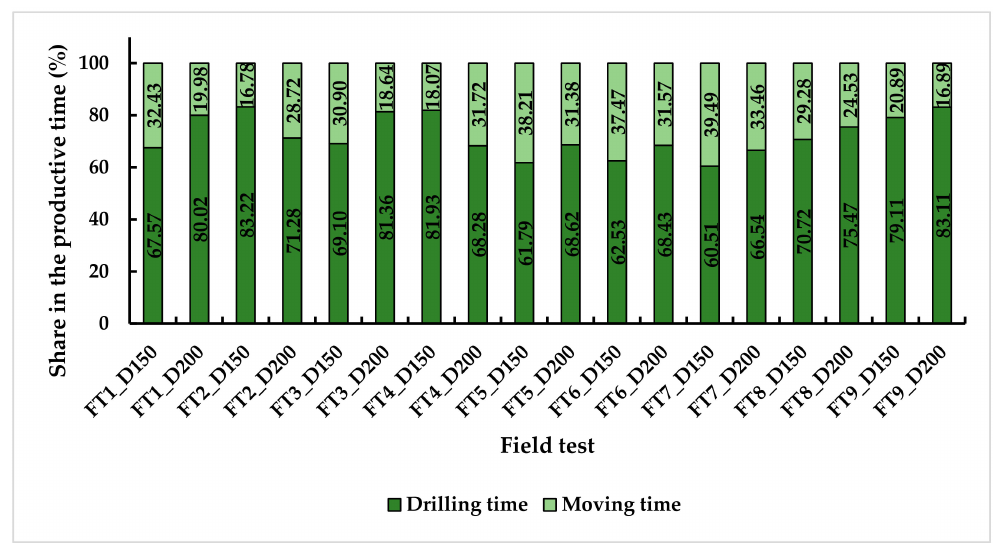
Figure 5. Shares of pit-drilling and moving time in the productive time in regard to field tests and drill sizes. Legend: FT1 to FT9 stand for the field tests 1 to 9; D 150 and D 200 stand for the two tested drill